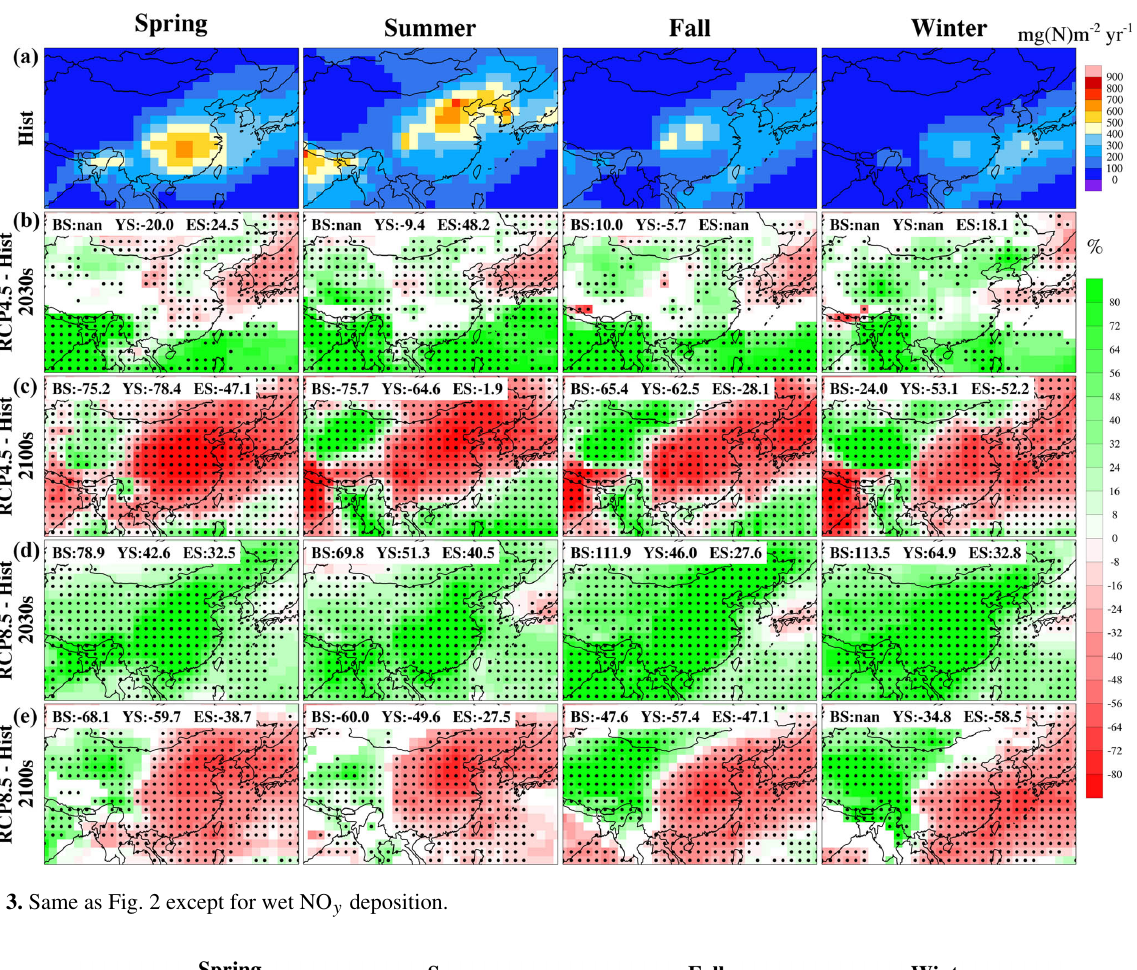
Figure 3. Same as Fig. 2 except for wet NO y deposition.